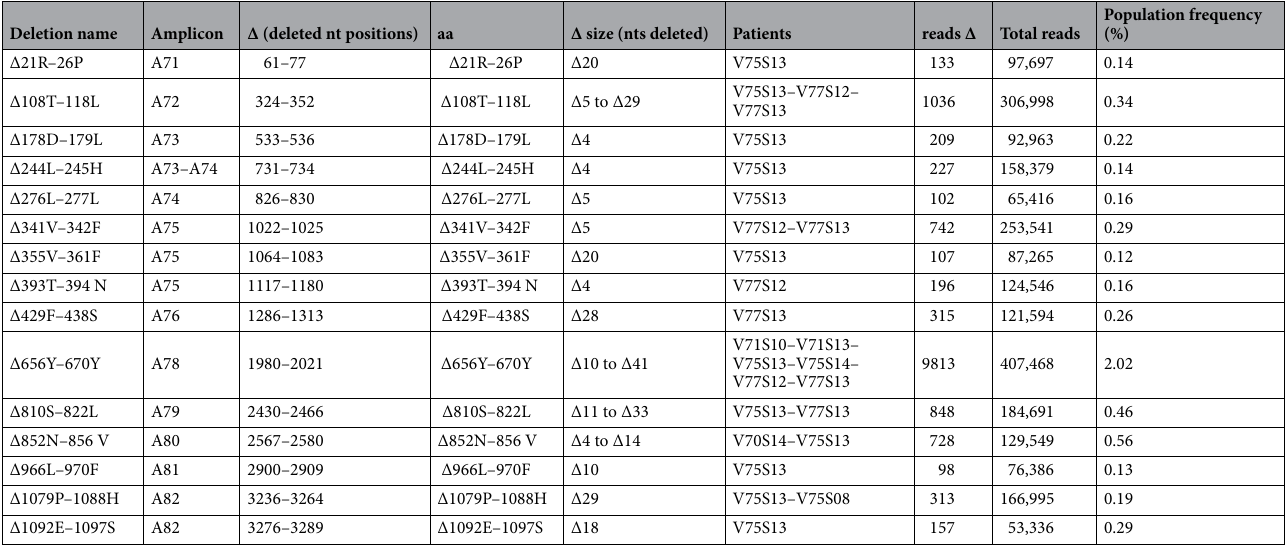
Table 3. Variant B.1.177.